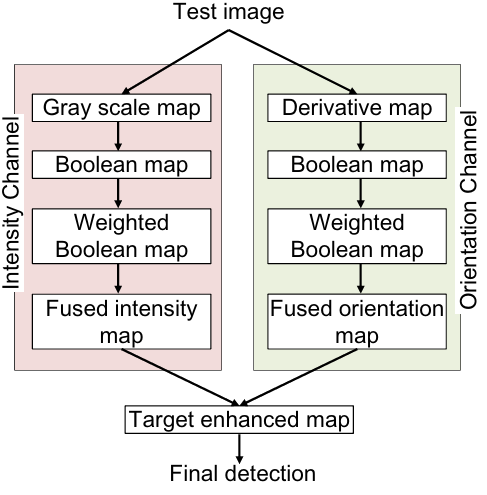
Figure 3. BMVT-based small IR target detection flow